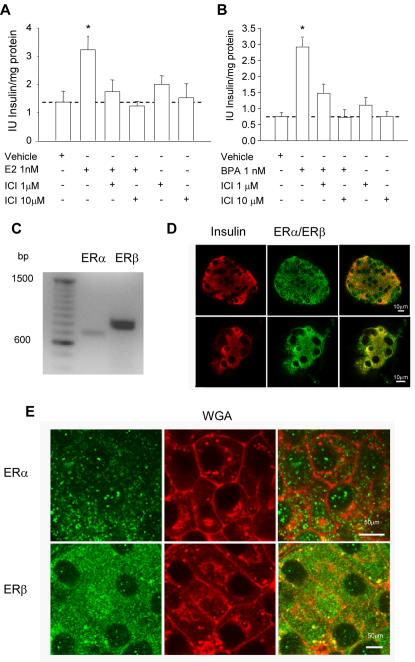
Involvement of estrogen receptors in E2 regulation of insulin content.(A) Insulin content obtained in cultured islets exposed to 1 nM E2 in the presence or absence of the antiestrogen ICI 182,780. (n≥4, from at least 4 mice), ** p<0.001, compared to vehicle. (B) Insulin content obtained in cultured islets exposed to 1 nM BPA in the presence or absence of the antiestrogen ICI 182,780. (n = 4, 8 mice), ** p<0.01, compared to vehicle. (C) RT-PCR of mRNA from fresh isolated islets was performed for both ERα and ERβ. (D) Confocal images of whole islets stained with anti-insulin (red) and anti-ERα or anti-ERβ (green). (E) ERα and ERβ subcellular localization. Single confocal images of whole islets stained with wheat germ agglutinin (red) as a marker for plasma membrane along with anti-ERα or anti-ERβ (green). Calibration bars represent 50 µm.